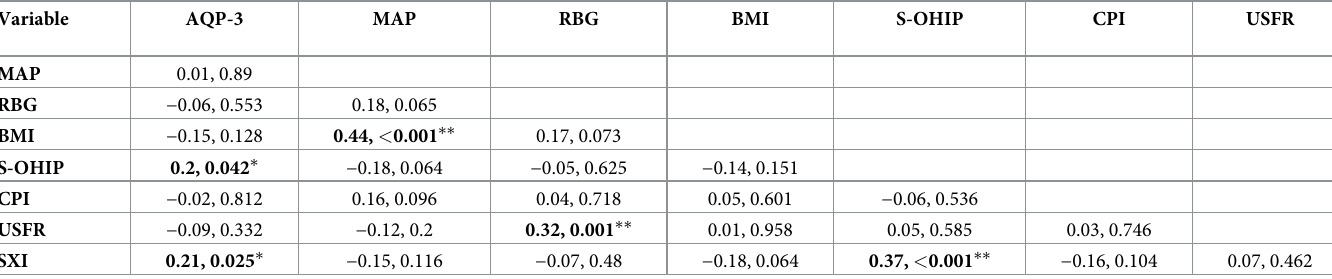
Table 4. Correlations between variables in patients with periodontal